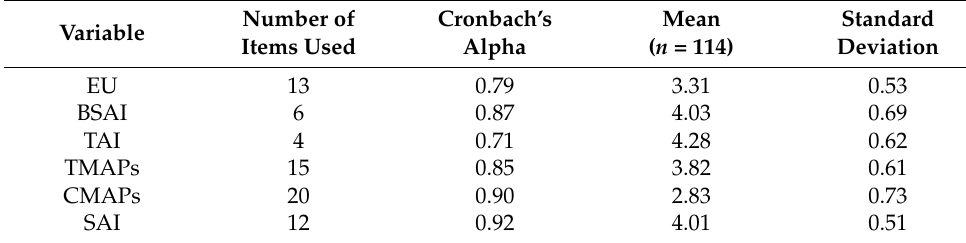
Table 2. Reliability and descriptive statistics of